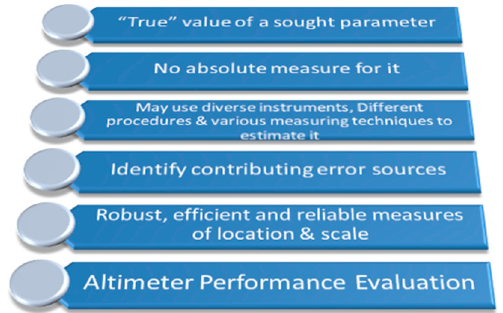
Figure 4. Steps to appraise altimeter system performance are shown above.